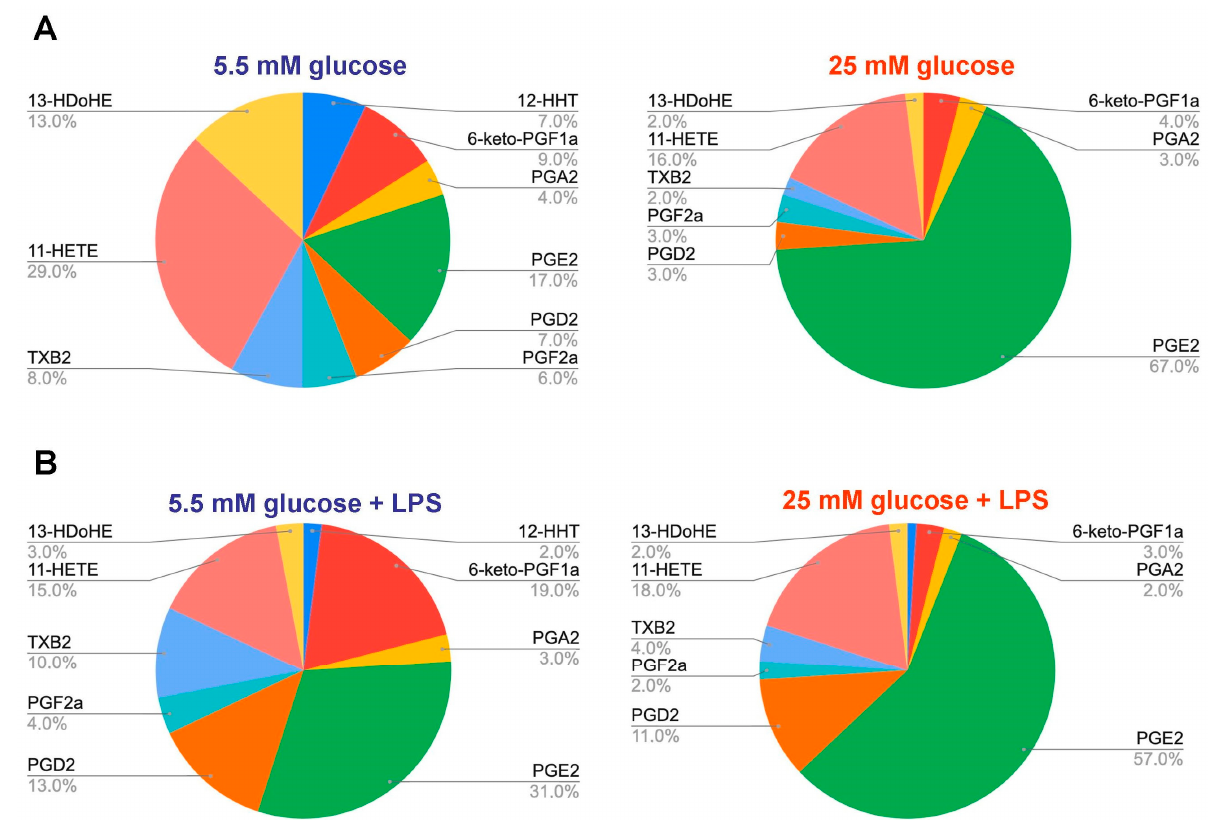
Figure 2. Comparison of COX-mediated metabolites in astrocytes, cultivated in normal (5.5 mM) and high (25 mM) glucose medium. Primary rat astrocytes were cultivated in normal (5.5 mM) or high (25 mM) glucose medium and then stimulated with lipopolysaccharide (LPS, 100 ng/mL) for 4 h. Concentrations of oxylipins in supernatants were measured using ultra-performance liquid chromatography-tandem mass spectrometry (UPLC-MS/MS). Pie plots showing the distribution of COX-mediated metabolites, released from ( A ) naive or ( B ) LPS-stimulated astrocytes. Abbreviations: TXB2-thromboxane B2, HETE-hydroxyeicosatetraenoic acids, HDoHE-hydroxydocosahexaenoic acids, HHT-hydroxyheptadecatrenoic acid, 6-keto-PGF1a-6-keto-prostaglandin F1a, PGA2-prostaglandin A2, PGJ2-prostaglandin J2, PGE2-prostaglandin E2, PGD2- prostaglandin D2, PGF2a-Prostaglandin